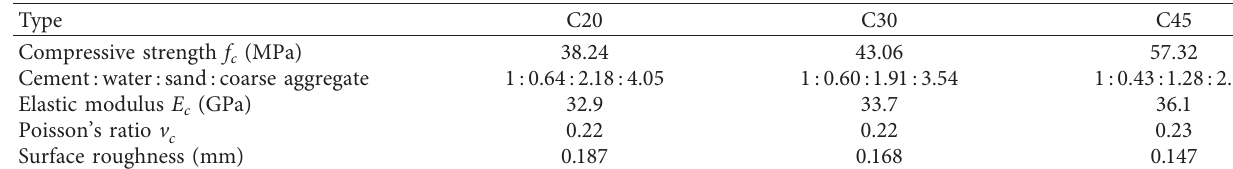
Table 1: Mix proportions and mechanical properties of concrete.